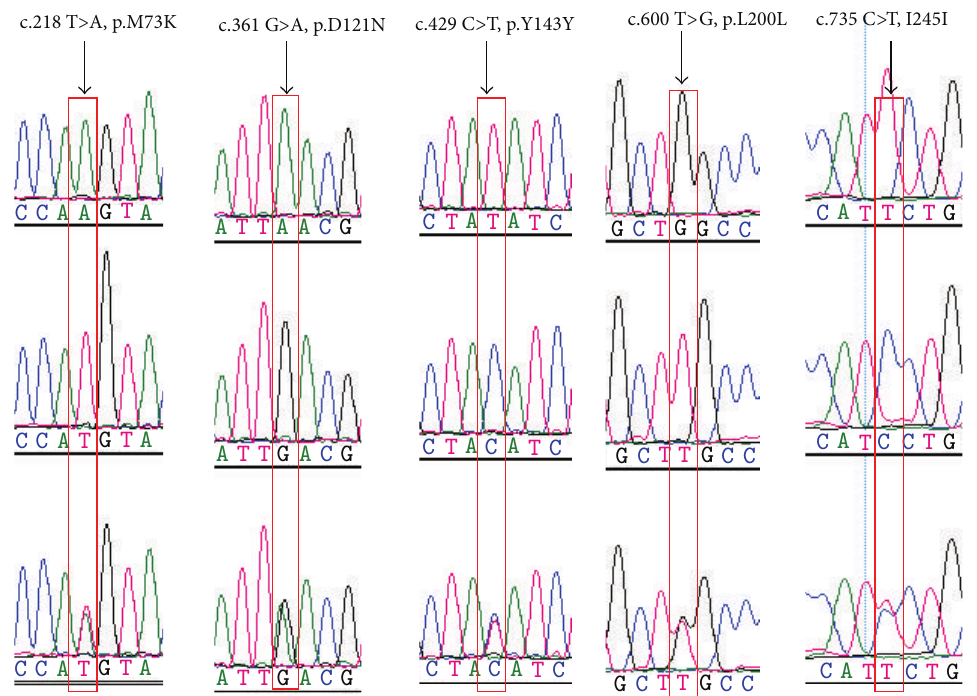
Figure 2: Identified SNPs and alignment of the MC1R protein regions around the deduced amino acid substitutions.